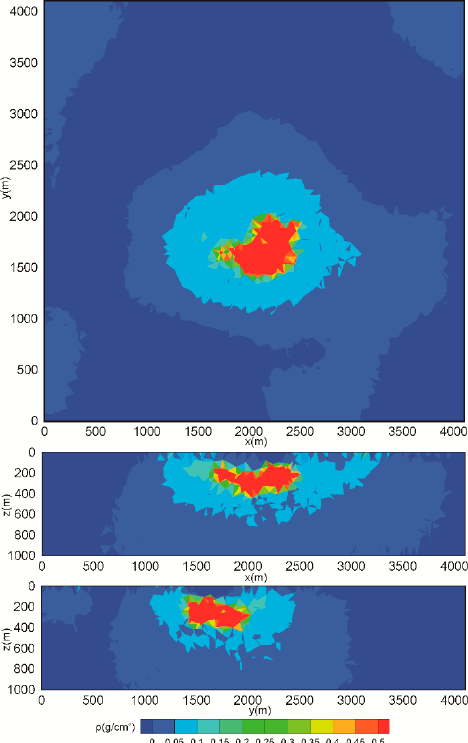
Figure 11. Improved FCM clustering inversion result of Vinton Dome on ( a ) x-y-plane at z = 0.3 km; ( b ) x-z-plane at y = 1.7 km; ( c ) y-z-plane at x = 2.2 km.